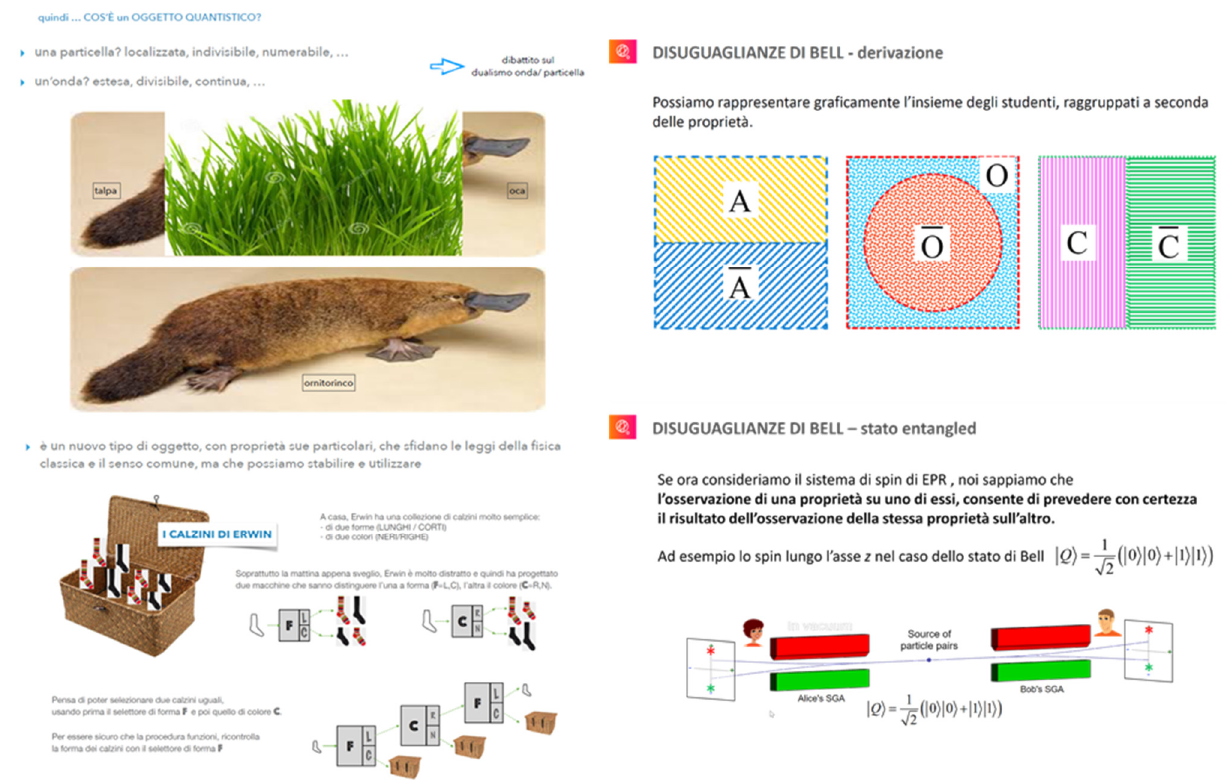
Figure 6. Fourth lecture: recap of the concepts and discussion of theory interpretations. Screenshots of the slides used during the lecture. Left : What is a quantum object? Right : concept of properties ( top ) and entanglement ( bottom ).